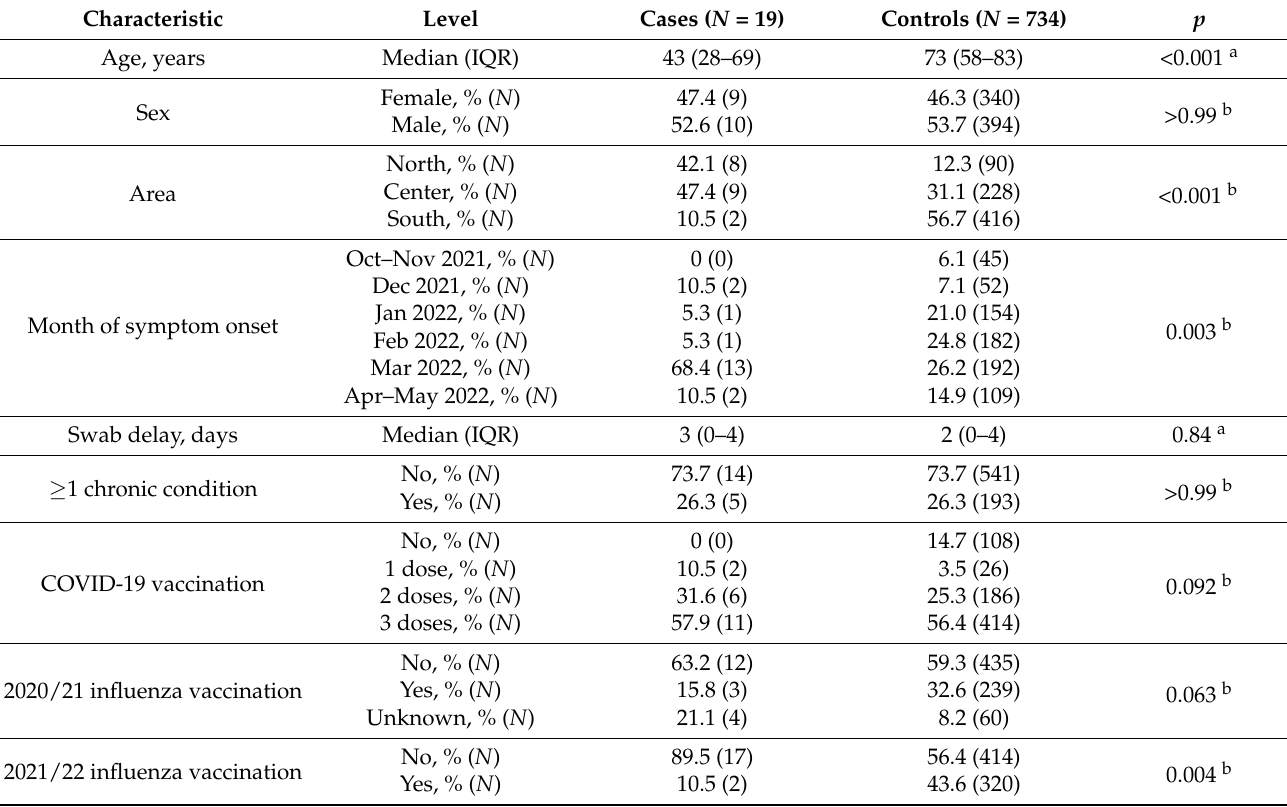
Table 2. Comparison of cases and